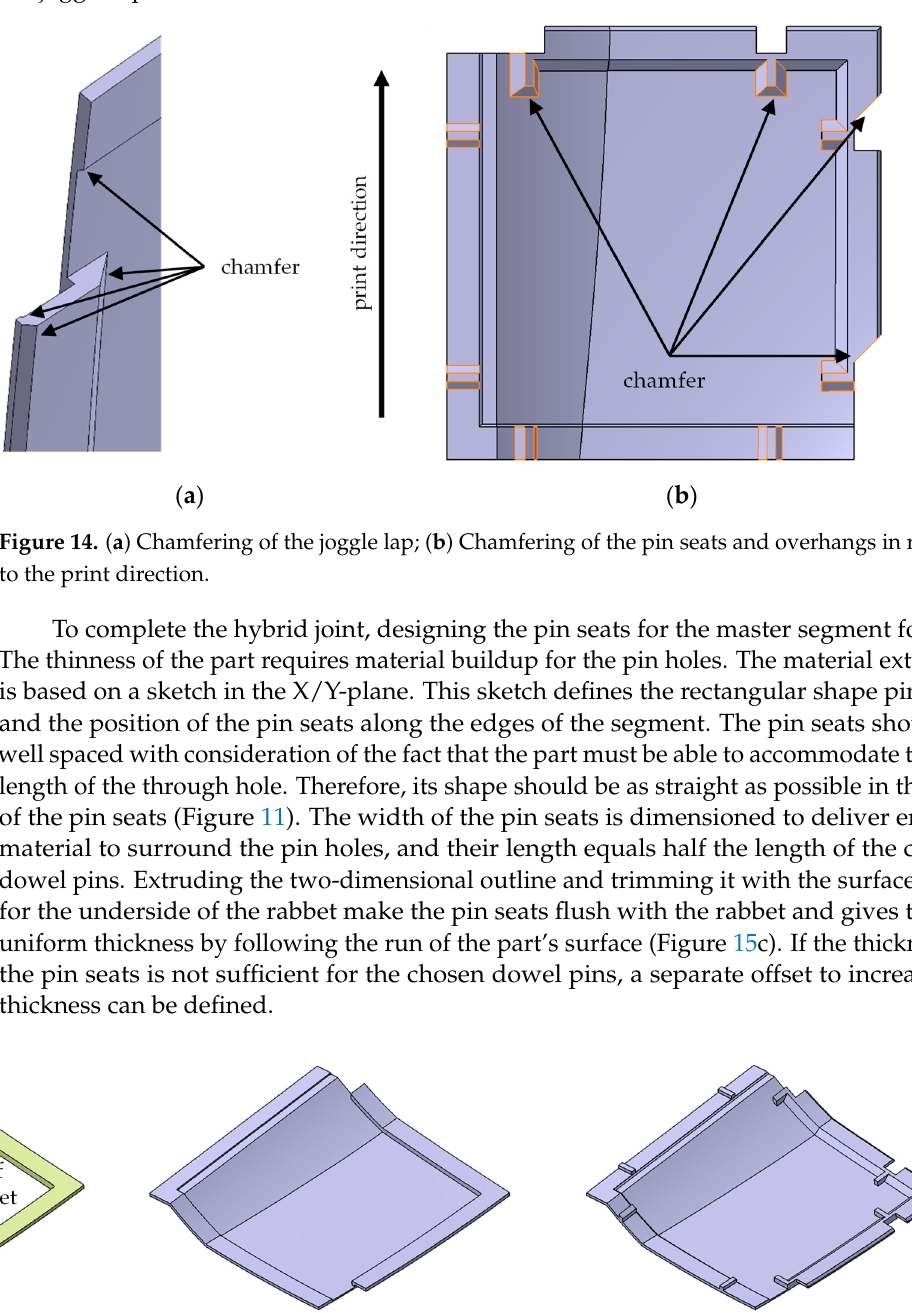
Figure 13. ( a )Areas of the rabbet formed by boundary planes; ( b ) Areas of the tongue formed by boundary planes; ( c ) Boundary planes limiting the circumference After deriving the shells of rabbet and tongue from trimming the surface offsets with